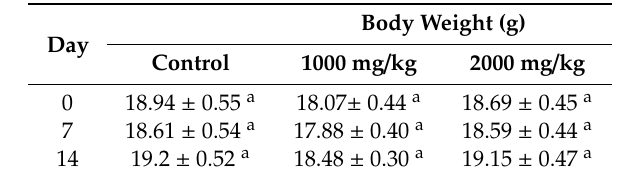
Table 1. E ff ect of phytic acid-chitosan-magnetic iron oxide nanoparticles (IP 6 -CS-MNPs) on mouse body weight.